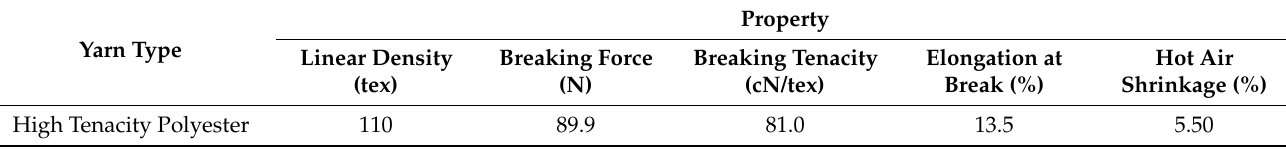
Table 1. Properties of 110 tex pre-activated high tenacity (HT) polyester yarn.